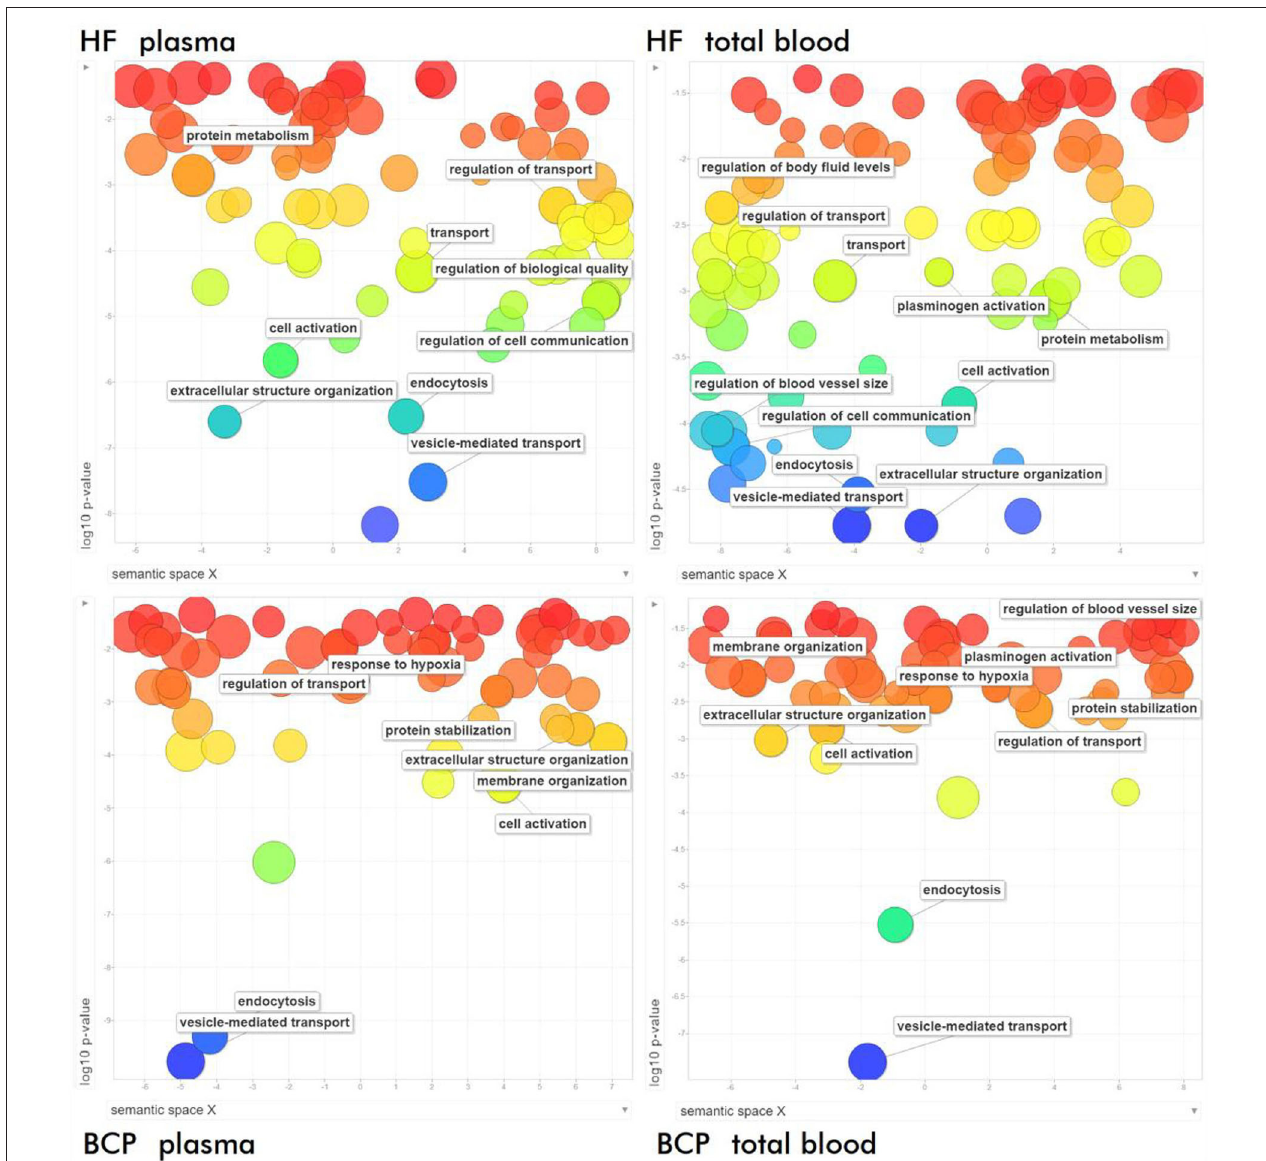
FIGURE 7 | Semantic similarity-based scatterplots of the results of GO functional enrichment analysis of exosomal proteins from BCPs and HFs by Biological Processes obtained via STRING (https://string-db.org/) after redundancy reduction via REVIGO (https://www.irb.hr/).